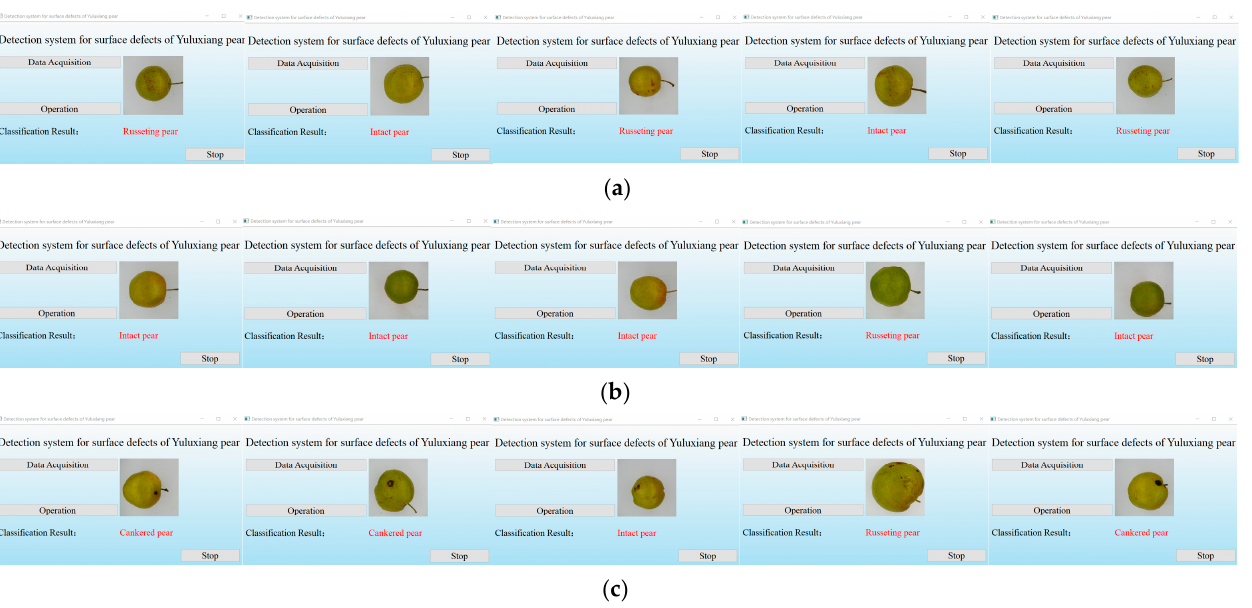
Table 6. Results of testing set based on detection system.